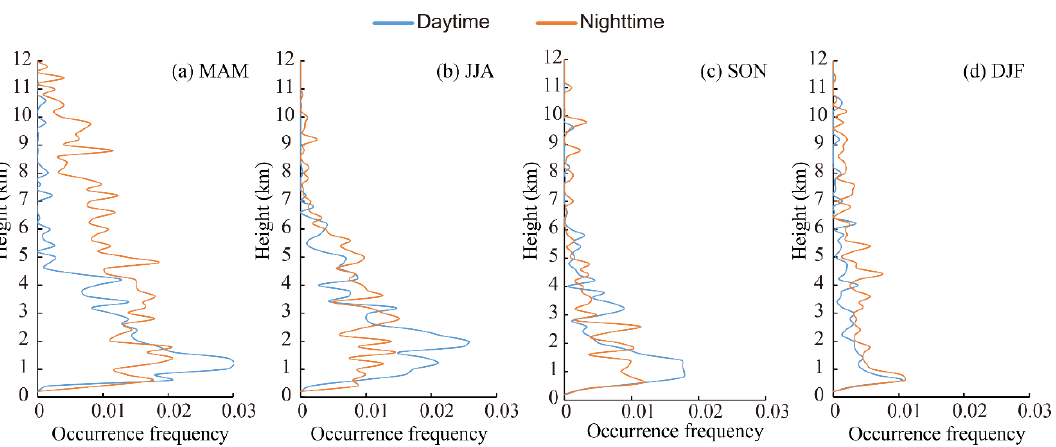
Figure 5. Vertical distribution of occurrence frequencies of dust layer in the daytime and nighttime in the Aral Sea region from CALIPSO observations for four seasons.